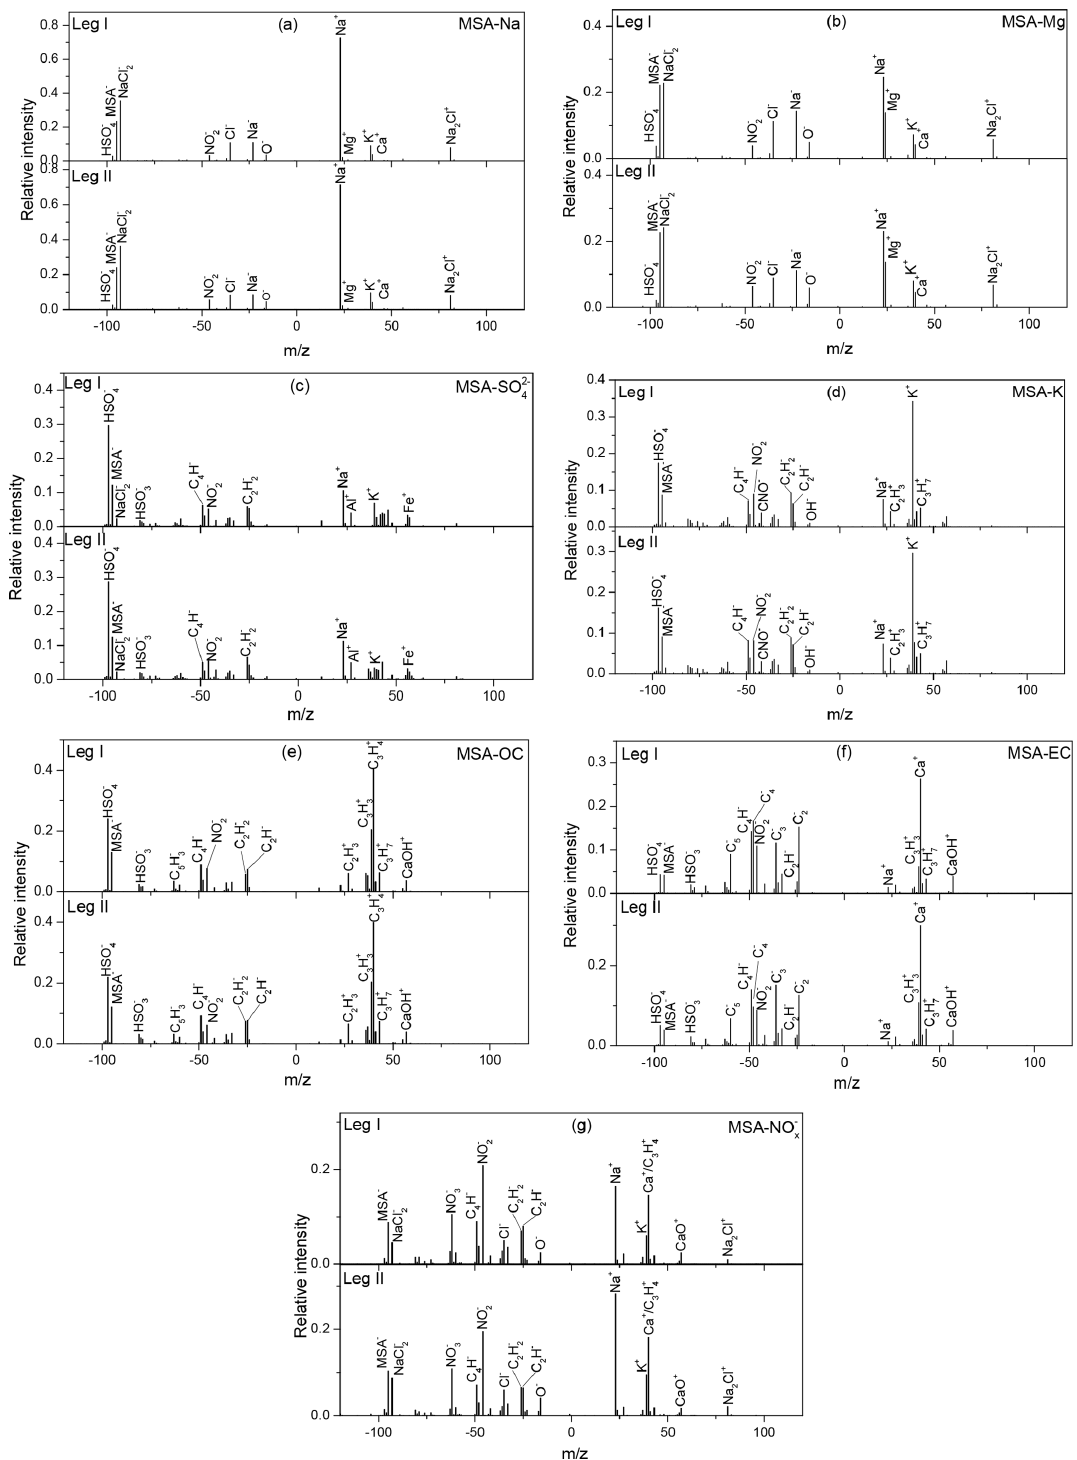
Figure 3. Average mass spectra of major MSA clusters during leg I and leg II. (a) MSA-Na, (b) MSA-Mg, (c) MSA-SO 2 − (e) MSA-OC, (f) MSA-EC, and (g) MSA-NO − x